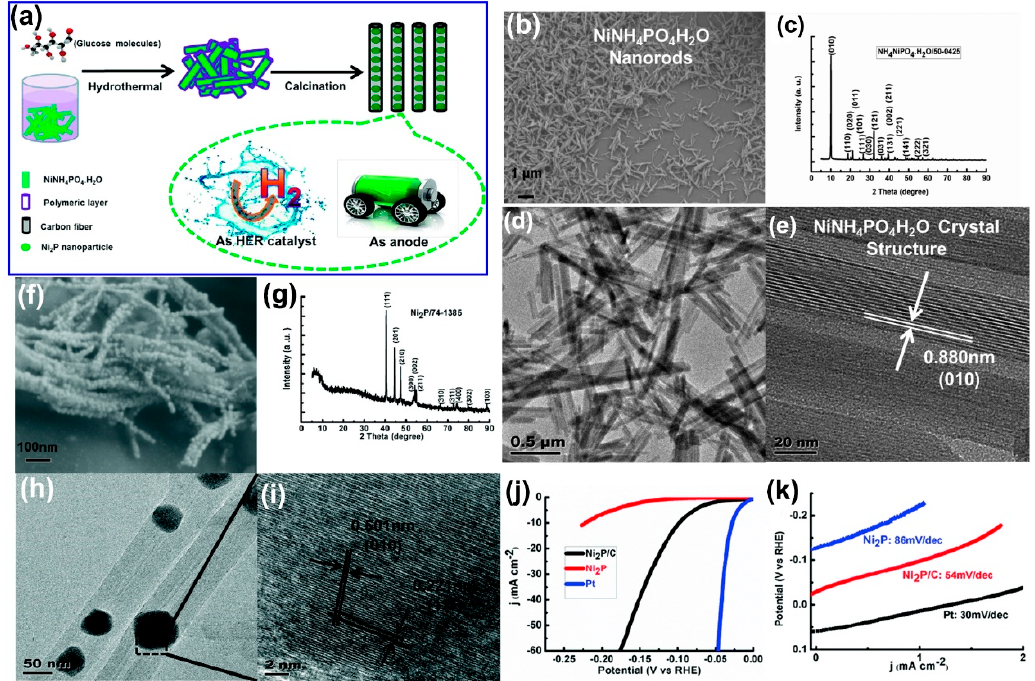
Figure 12. Schematic illustration of the synthetic procedure for the peapod-like Ni 2 P / C nanocomposites ( a ), SEM image ( b ), XRD pattern ( c ), TEM ( d ), and HRTEM ( e ) images of NiNH 4 PO 4 · H 2 O nanorods. SEM image ( f ), XRD pattern ( g ), TEM ( h ), and HRTEM ( i ) images of Ni 2 P / C composites. Polarization curves ( j ) and corresponding Tafel plots ( k ) for Ni 2 P and Ni 2 P / C electrodes in 0.5 M H 2 SO 4 . Reproduced with permission from Reference [127], Copyright The Royal Society of Chemistry, 2015.